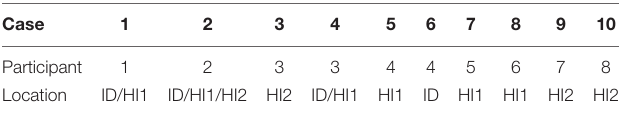
TABLE 2 | Heart rate cases (Hill, 2019).